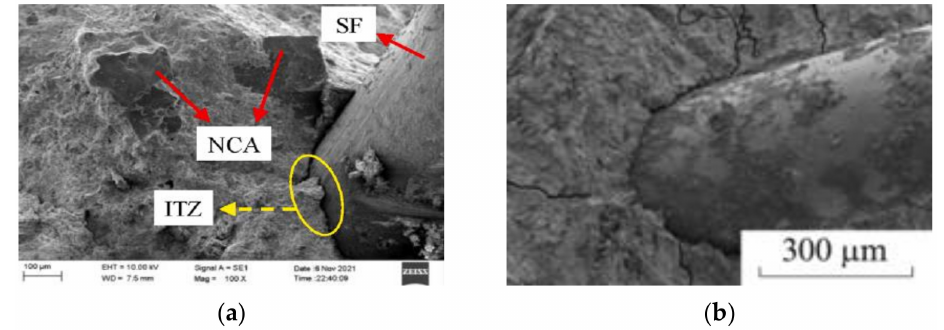
Figure 10. Distribution of Steel fibers in concrete: ( a ) [28]; ( b )